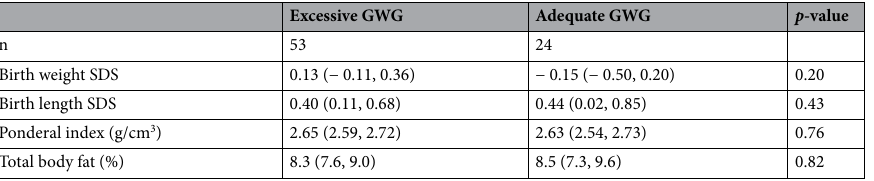
Table 2. Neonatal anthropometry and body composition measured in the offspring according to maternal gestational weight gain (GWG). Data are model-adjusted means and the respective 95% confidence intervals (CI) derived from general linear models, including maternal body mass index (BMI) in mid-gestation, and adjusted for child’s sex, gestational age at birth, and trial group allocation; mid-parental height SDS was also added as a covariate for length SDS. Body composition (total body fat) was measured at 2 to 3 weeks postpartum. SDS, standard deviation score.